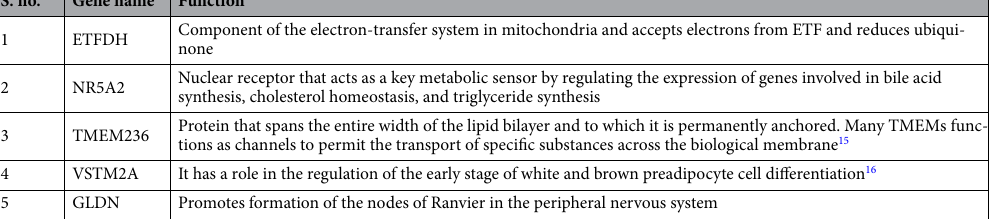
Table 1. List of genes significant for classifying CRC dataset based on the literature.